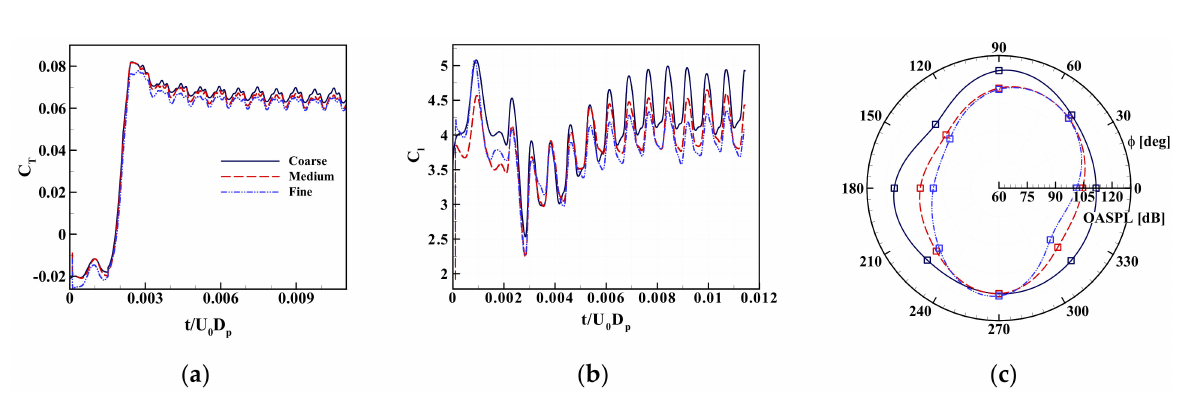
Figure 5. Grid study results: ( a ) time history of C T ; ( b ) time history of C l ; ( c ) directivity of OASPL.